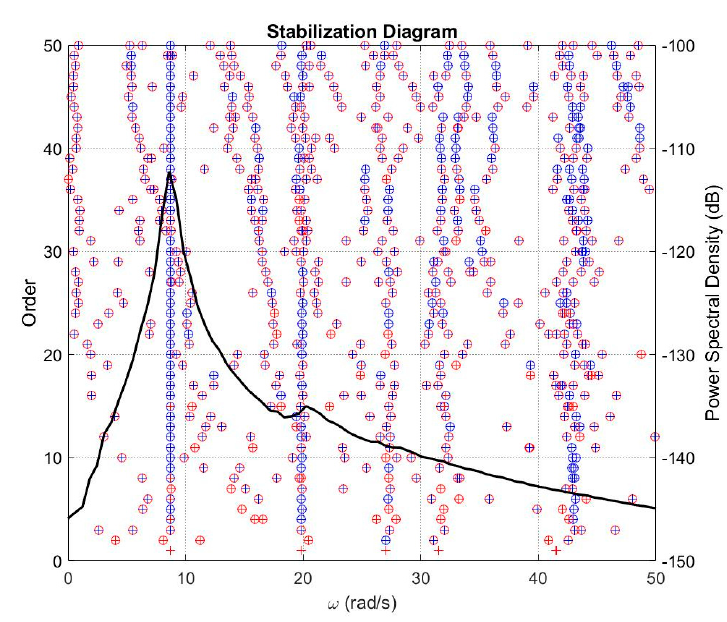
Figure 9. Stabilization diagram of six-DOF chain model with heavy damping. Table 2. Modal parameter identification result of six-DOF chain model with heavy